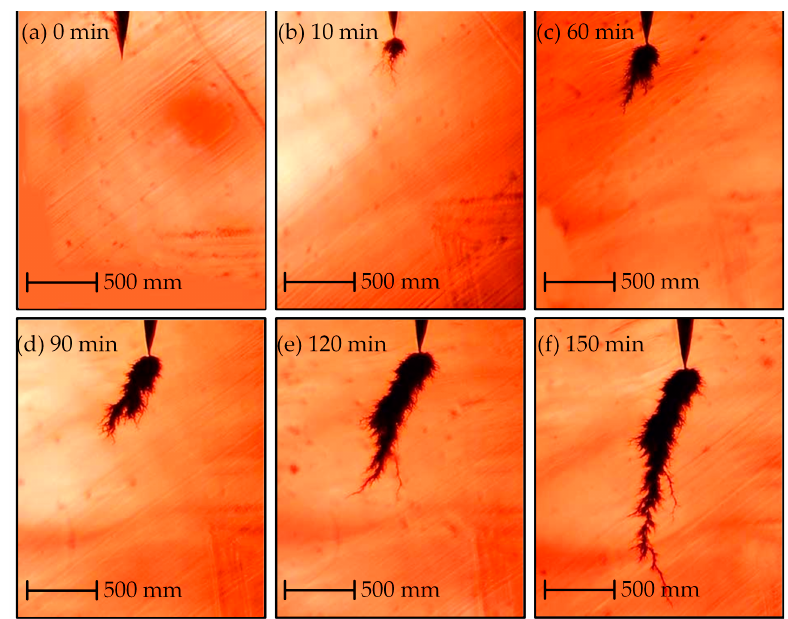
Figure 8. Growth characteristics of the electrical tree in sliced cable at 70 °C.